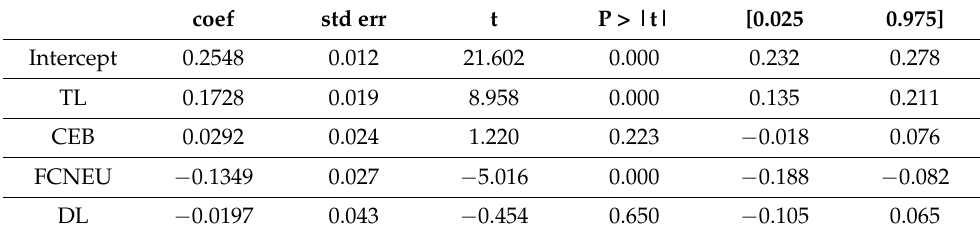
Table 4. Results of the first stage of